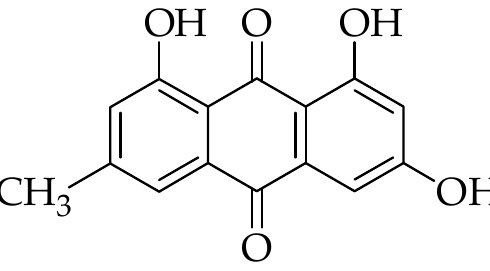
Figure 5. The chemical structure of emodin.